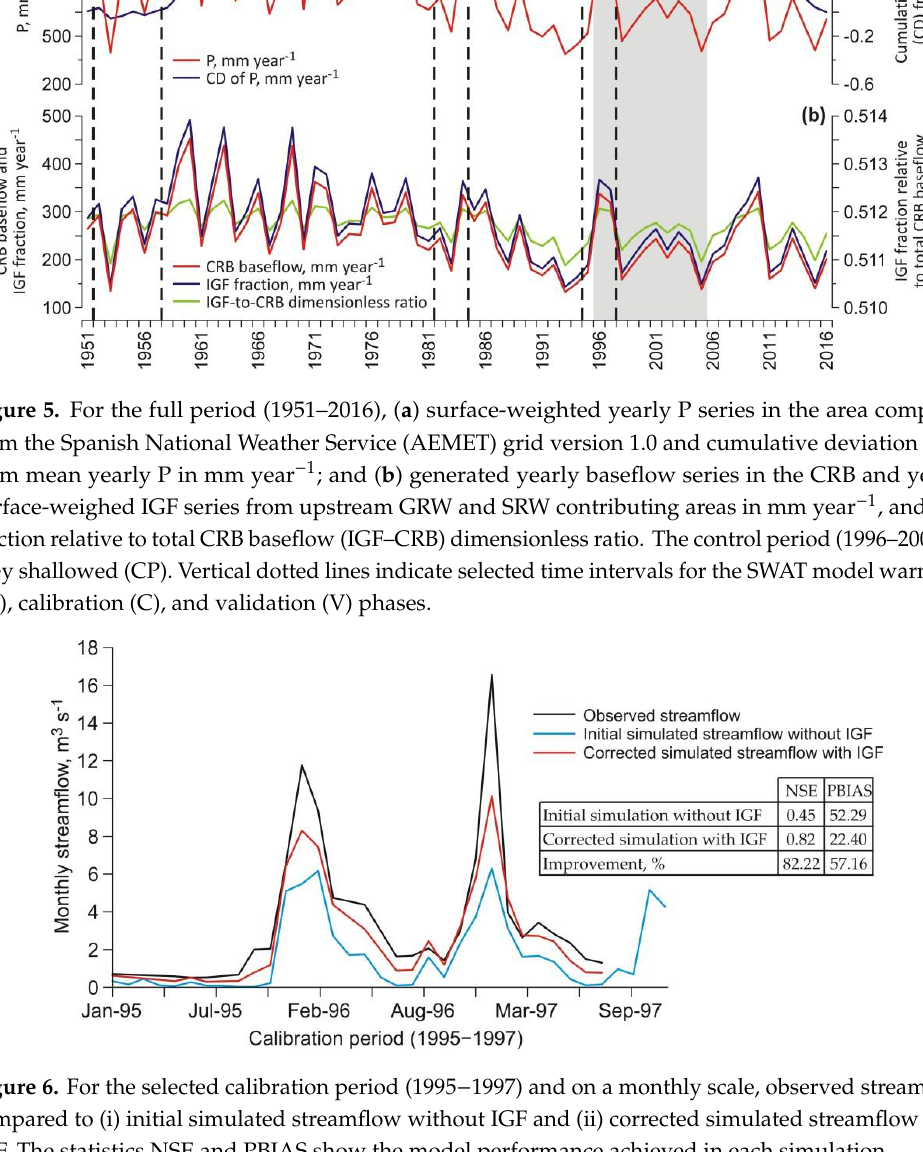
Figure 5. For the full period (1951–2016), ( a ) surface-weighted yearly P series in the area compiled from the Spanish National Weather Service (AEMET) grid version 1.0 and cumulative deviation (CD) from mean yearly P in mm year −1 ; and ( b ) generated yearly baseflow series in the CRB and yearly surface-weighed IGF series from upstream GRW and SRW contributing areas in mm year −1 , and IGF fraction relative to total CRB baseflow (IGF–CRB) dimensionless ratio. The control period (1996– 2005) is grey shallowed (CP). Vertical dotted lines indicate selected time intervals for the SWAT model warm-up (W), calibration (C), and validation (V) phases.